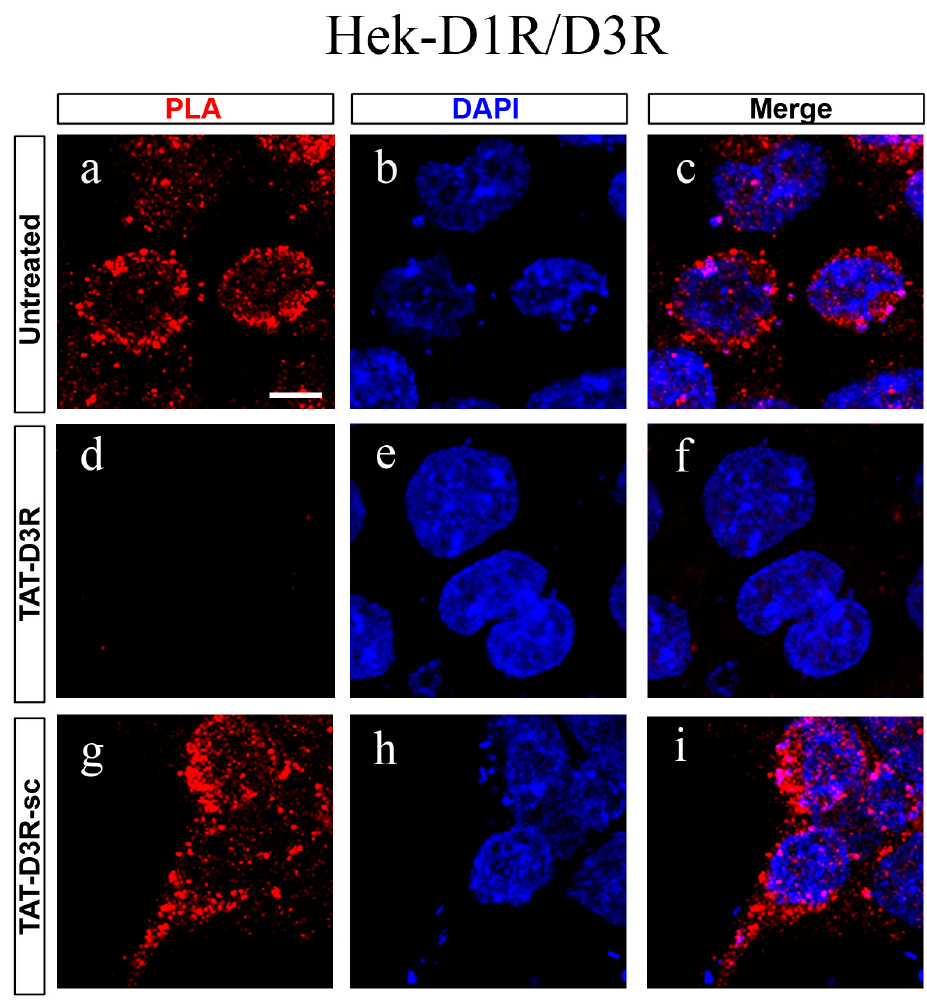
Figure 1. Detection of D1R/D3R heteromer with PLA in Hek293 cells expressing both D1R and D3R. Representative PLA image performed in Hek293 cells transiently expressing both D1R and D3R (Hek-D1R/D3R), untreated (panel a – c ) and pre-treated with TAT-D3R (1 µ M) (panel d – f ) or TAT-D3R-sc (1 µ M) (panel g – i ) for 24 h ( h ); specific anti-D1R and anti-D3R antibodies were used. PLA signals appear as red spots; nuclei are detected with DAPI (blue). Scale bar = 20 μ m. Hek-D1R/D3R cells were then treated with the D1R agonist SKF81297 in combination with the D2R/D3R agonist quinpirole (both 1 µ M) for 5, 15 or 30 min (Figure 2A). Analysis of p-Erk1/2 levels showed that D1R and D3R co-stimulation transiently promoted Erk1/2 phosphorylation, reaching a peak at 5 min of stimulation; by contrast, the same treatment did not increase p-Akt levels (Figure 2A,C). Moreover, in Hek-D1R/D3R cells, Erk1/2 phosphorylation induced with SKF81297/quinpirole (both at 1 μ M; 5 min) was specifically prevented by H89 (1 μ M) (Figure 2D,E), while pre-incubation with LY294002 (10 μ M) or with PTX (100 ng/mL) did not modify SKF81297/quinpirole-induced Erk1/2 phosphoryla- tion (Figure 2D–F). Similar results were obtained by stimulating Hek-D1R/D3R cells with dopamine (DA) (1 μ M). Indeed, analysis of p-Erk1/2 and p-Akt levels showed that DA transiently promoted Erk1/2 (peak at 5 min) but not Akt phosphorylation (Figure 2G–I); moreover, Erk1/2 phosphorylation induced by DA was specifically prevented by H89 (1 μ M) but not by LY294002 (10 μ M) or by PTX (100 ng/mL) (Figure 2J–L). Therefore, in Hek- D1R/D3R cells, co-stimulating D1R and D3R results in the selective activation of the Erk1/2 cascade, an effect requiring PKA, thus resembling the intracellular signaling acti- vated by the D1R when individually expressed.